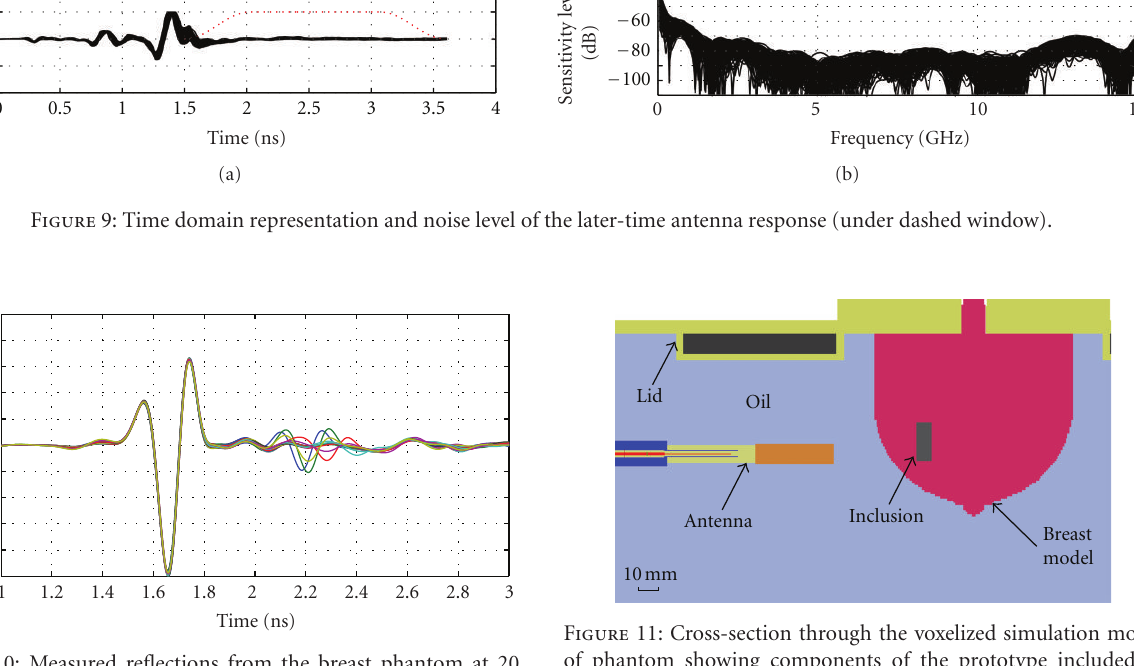
Figure 10: Measured reflections from the breast phantom at 20 antenna locations encircling the model. Measurements are collected with the antennas positioned at the same z -location as the inclusion.